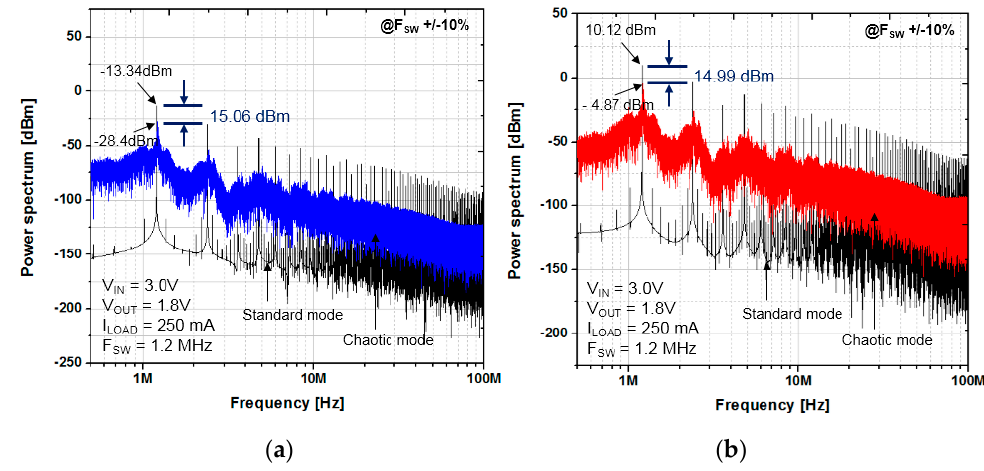
Figure 11. Simulated power spectrum in chaotic mode (with slope modulation) with F SW +/ − 10% (1.08 MHz to 1.32 MHz): ( a ) Output node; ( b ) Switching node (@V DD = 3.0 V, Vo = 1.8 V, Io = 500 mA, L = 2.2 µH, C = 2.2 µH).